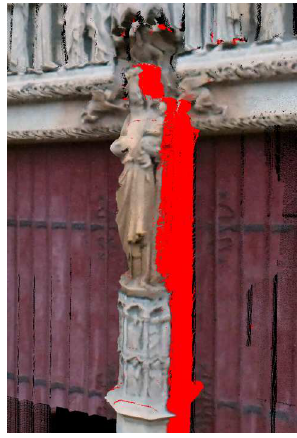
Figure 7: Evolution of the residual error during the servoing With the estimated camera pose c M o , the visible points of PC m are projected in the digital image I ∗ (figure 6a) and are colorized.